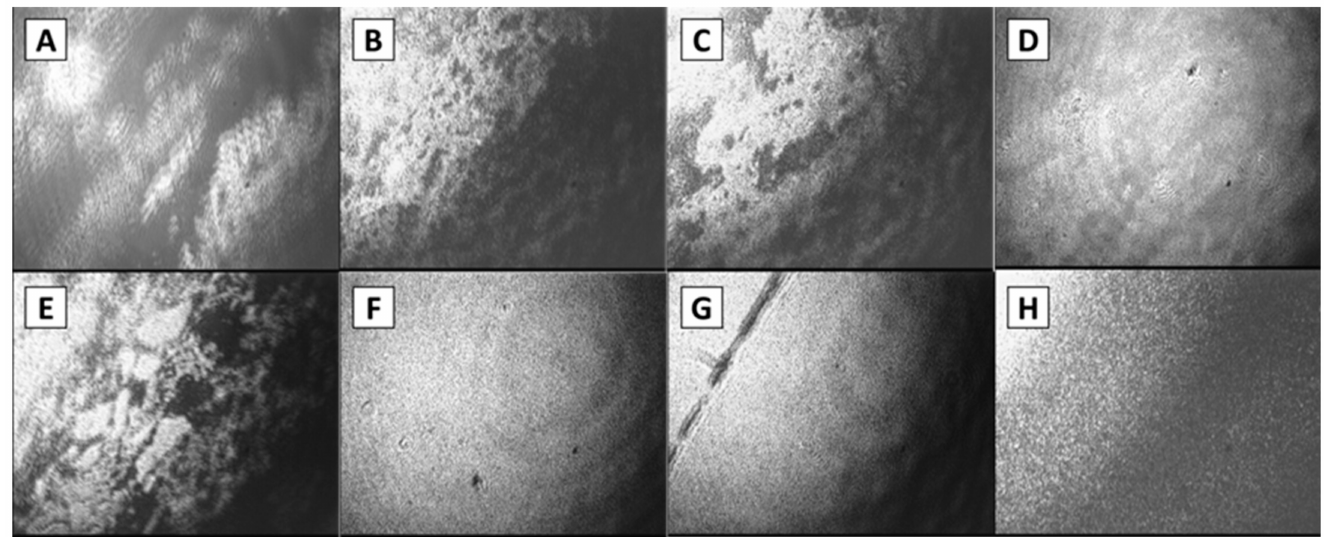
Figure 6. BAM images of spread LYS microgel layers on phosphate buffer. The microgel was purified by a three-cycle procedure of centrifugation and supernatant exchange. The images ( A – D ) correspond to layers of LYS microgel without EtOH. The images ( E – H ) correspond to layers of LYS microgel with the addition of EtOH to improve spreading. The images ( A , B ) and ( E , F ) correspond to the increase in surface concentrations by successive additions of the microgel dispersion. The images ( C , G ) correspond to layers after mechanical destruction of the layer by a thin needle. The images ( D , H ) correspond to two-fold compressed layers after mechanical destruction by a thin needle. The image size is 1300 × 1000 microns.